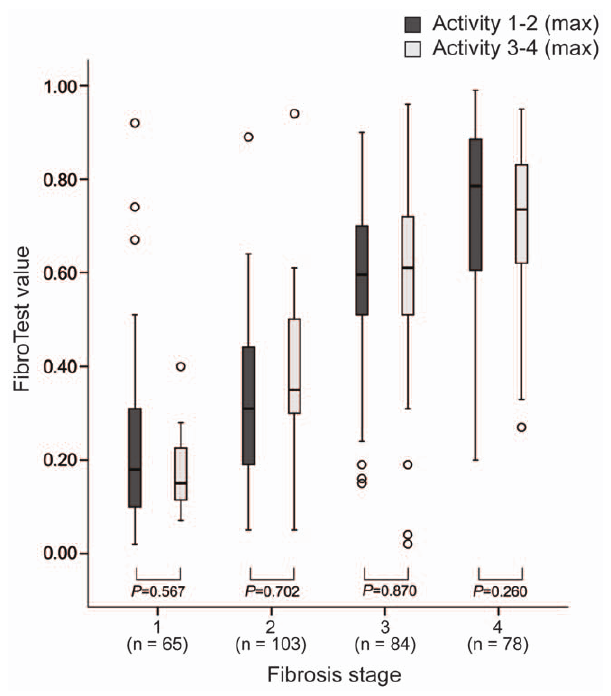
Figure 4. Distribution of FT values according to fibrosis stage and maximal activity grade 1–2 vs. 3–4. FT values were statistically equivalent between maximal activity grade 1–2 and 3–4 when stratified by each fibrosis stage (all P . 0.05).